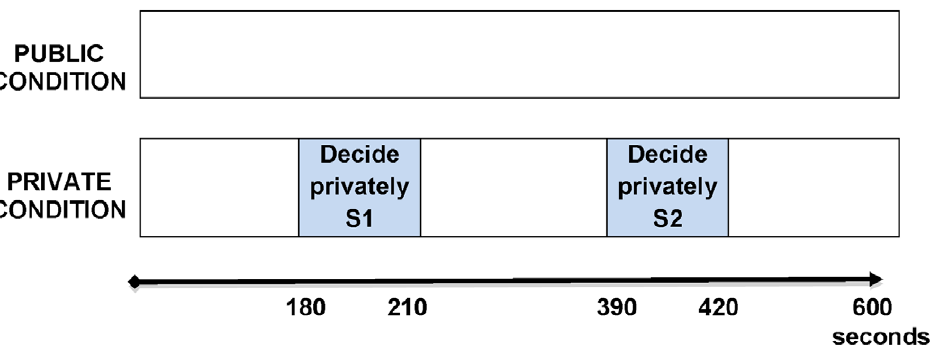
Figure 1. Timing of our two main conditions. In the Public Condition children make the decision to stop the time in view of all the other children. In the Private Condition, we gave children the additional possibility to stop the time privately within two periods of 30 seconds each (‘‘S1’’ after 180 seconds and ‘‘S2’’ after 390 seconds). In these periods children could decide to stop the time privately using a specific report sheet previously distributed by the